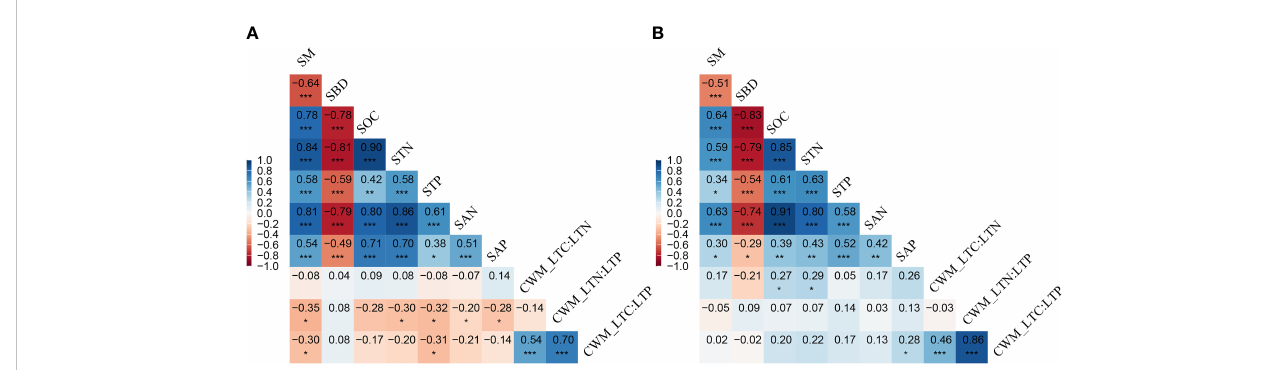
FIGURE 6 Correlation between plant stoichiometry traits and soil properties. Plant stoichiometry traits include CWM_LTC : LTN, CWM_LTN : LTP, and CWM_LTC : LTP, and soil properties include soil moisture (SM), soil bulk density (SBD), soil total organic carbon (SOC), total soil nitrogen (STN), total soil phosphorus (STP), soil-available nitrogen (SAN), and soil-available phosphorus (SAP). * represents P < 0.05, ** represents P < 0.01, *** represents P < 0.001, (A) alpine meadow, (B) alpine